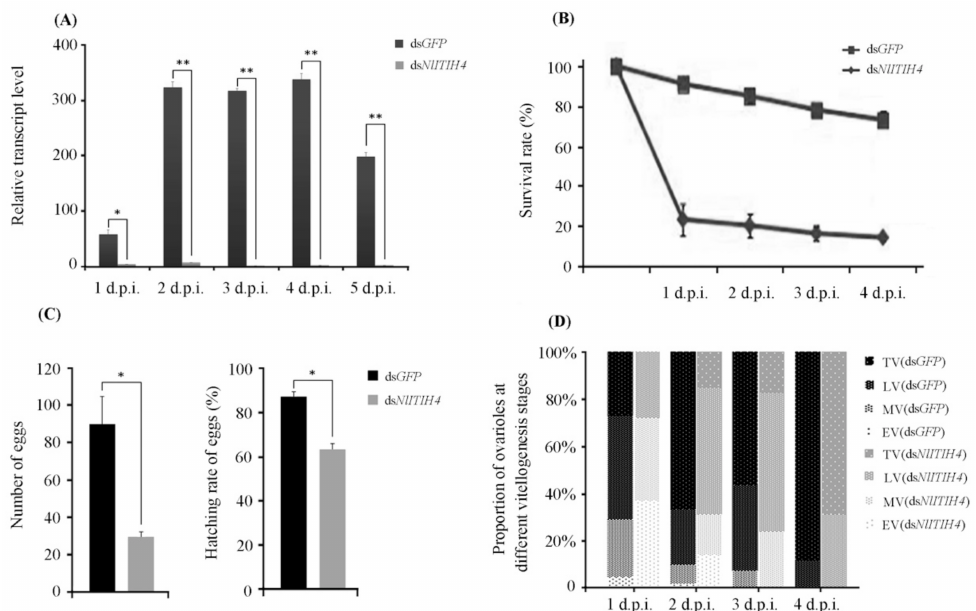
Figure 4. Effects of ds NlITIH4 injection on the growth and reproduction of N. lugens : ( A ) the efficiency of RNAi by ds NlITIH4 injection at 1 to 5 days post injection of dsRNA (d.p.i.); ( B ) effect of ds NlITIH4 injection on the survival of N. lugens at 1 to 4 d.p.i.; ( C ) effect of ds NlITIH4 injection on the number and hatching rate of eggs; and ( D ) effect of ds NlITIH4 injection on the vitellogenesis of ovarioles. EV (early vitellogenesis prophase), MV (middle vitellogenesis), LV (late vitellogenesis), and TV (terminal vitellogenesis) at 1 to 4 d.p.i. Data are expressed as mean ± SE. Significant differences: * p < 0.05, ** p < 0.01.